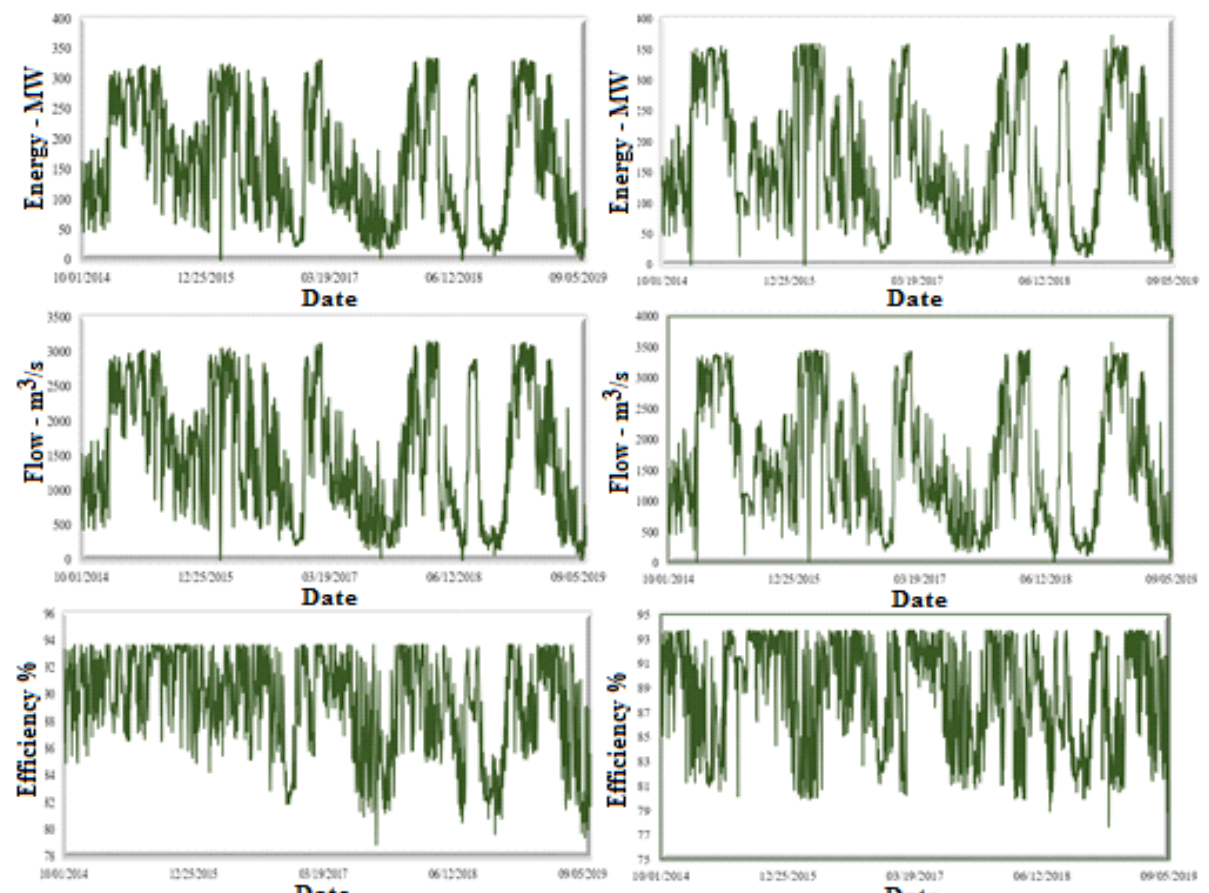
Figure 2. Data Course Line Graphs of Energy, Flow and Efficiency Parameters of Dogancay I and II HEPPs.